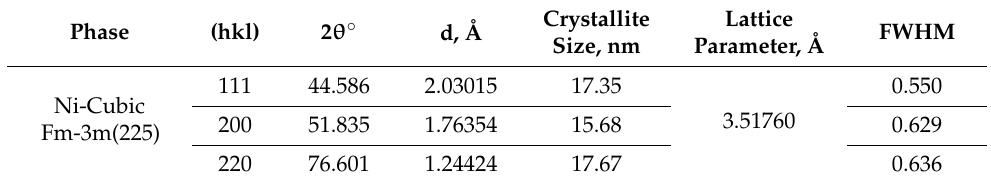
Figure 1. SEM image in ( a ) and XRD pattern in ( b ) of an array of Ni NTs in PET template. Similar results were previously obtained in [37,38]. Table 1. Structural parameters of Ni NTs.